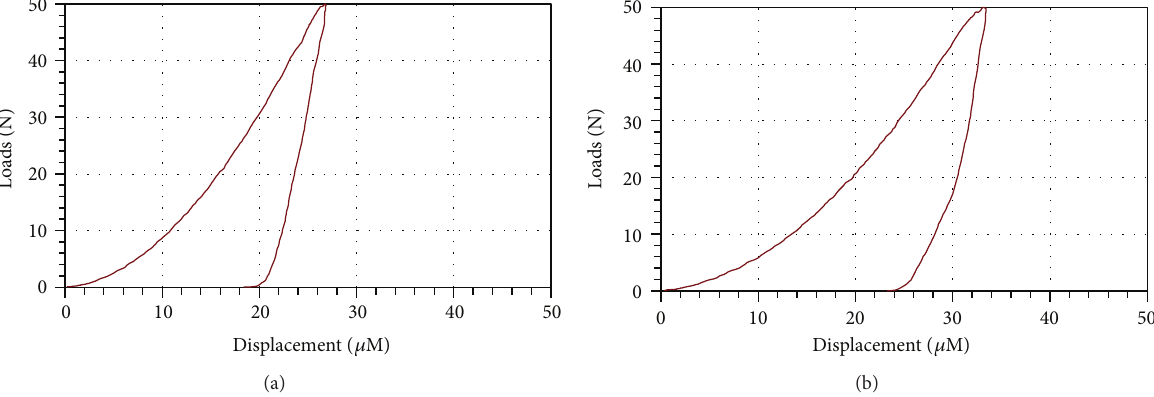
Figure 6: P - h curves during microhardness experiments with loading speed (0.2mm ⋅ min −1 ), under a maximum load (50N) of (a) Ti-6Al-4V, (b) Ti-6Al-7Nb.